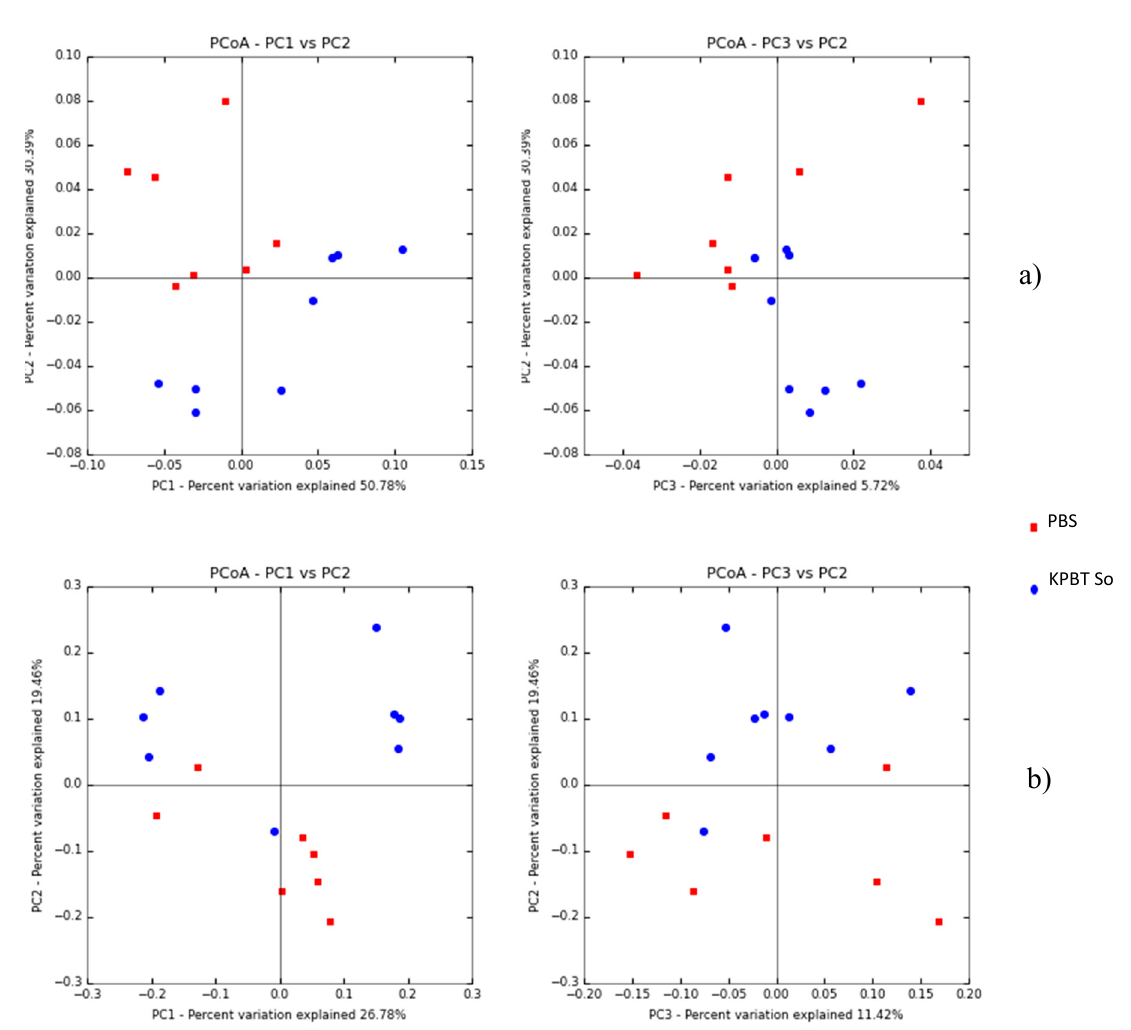
Figure 2. Principal coordinates analysis (PCoA) plots of the weighted ( a ) and unweighted ( b ) Unifrac distance metrics colored by protocols (KPBT So and PBS So) of non-pooled washes. Each dot represents an individual sample from one of the successive washes. All samples were rarefied at 6,524 sequences. Significant differences were observed between each protocol for both weighted and unweighted data.